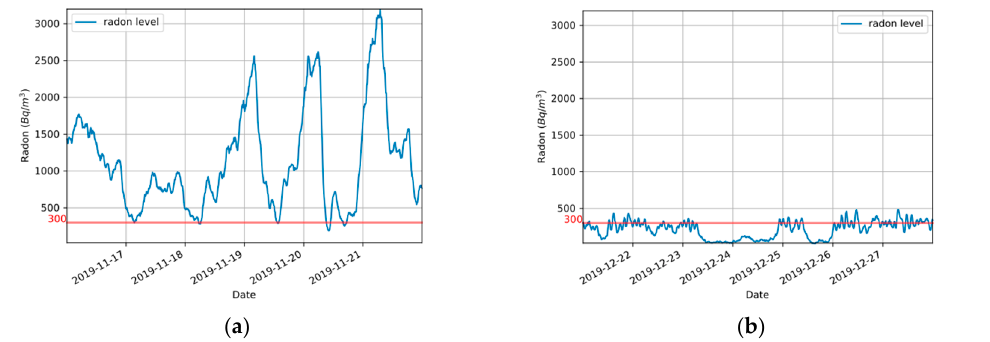
Figure 3. radon levels for the same location: ( a ) alert system deactivated, ( b ) alert system activated, and airflow control system operated by a